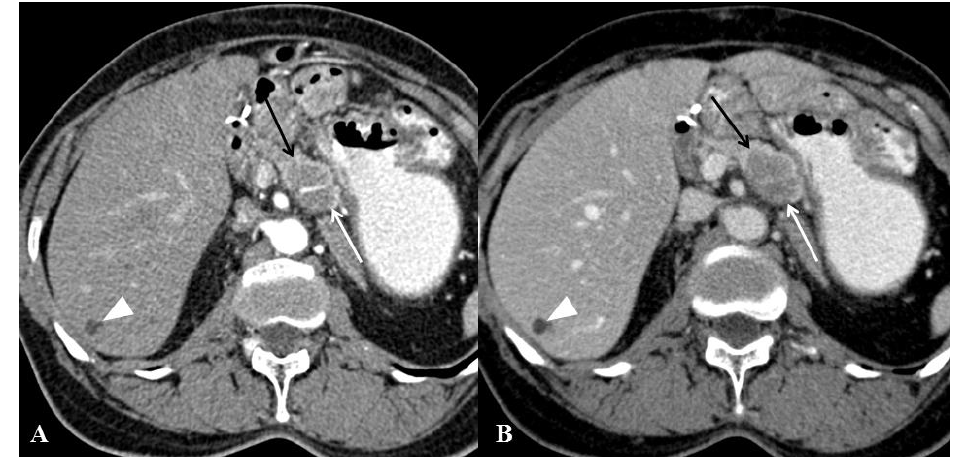
Figure 4. Computed tomography (CT) examination in a 64-year-old woman with prior history of gastric antral adenocarci- noma (pT3N2) treated by surgery and neoadjuvant radiochemotherapy three years before. ( A , B ) CT images of the abdomen in the axial plane obtained during the arterial ( A ) and portal venous ( B ) phases of enhancement show well-defined mass (arrows) with heterogeneous content of the pancreatic head. Hepatic lesion (arrowhead) was confirmed as benign biliary cyst and was already present on prior CT examinations. Endoscopic ultrasound-guided biopsy of the pancreatic mass revealed metastasis from gastric adenocarcinoma. After exclusion of local recurrence and other metastatic sites, the patient underwent left pancreatectomy with